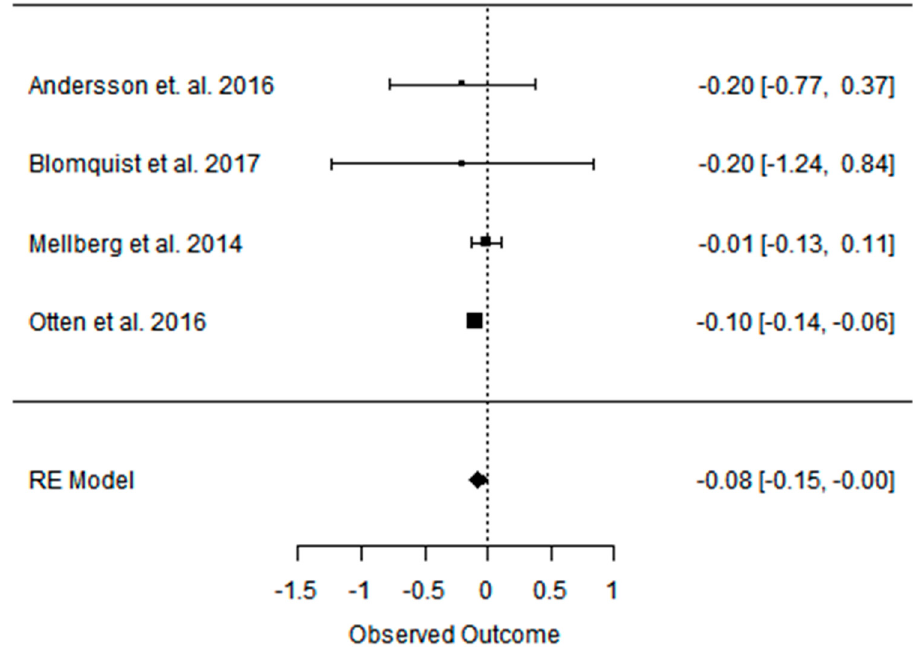
Figure A29. Forest plot of the effect of a CD on TG in the long term (weighted mean difference).